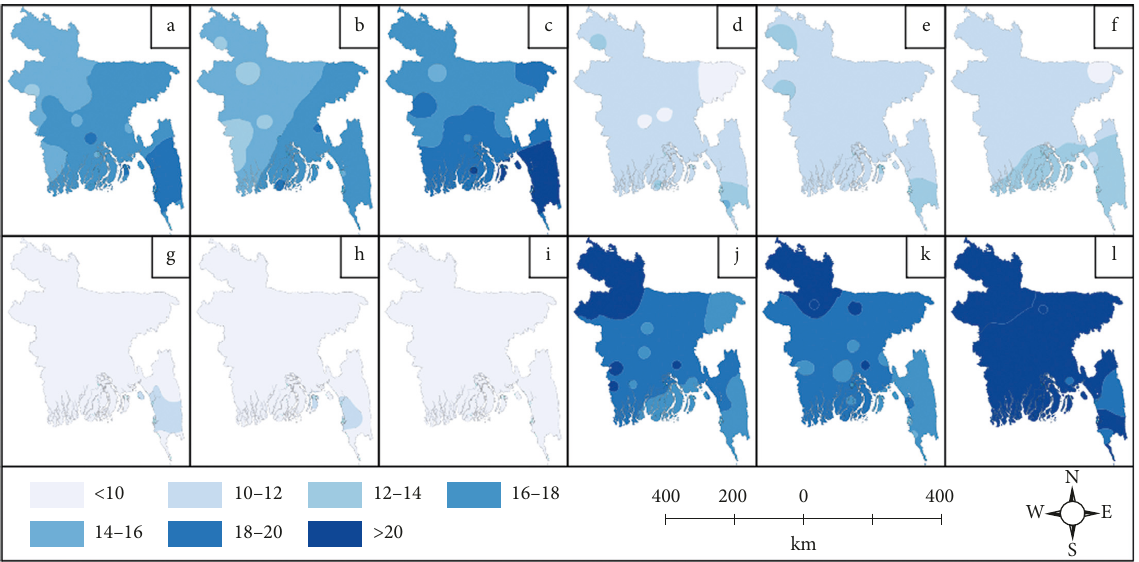
Figure 7: Decadal analysis of the three-month PCI for JFM during (a) 1980–1989, (b) 1990–1990, and (c) 2000–2011; AMJ during